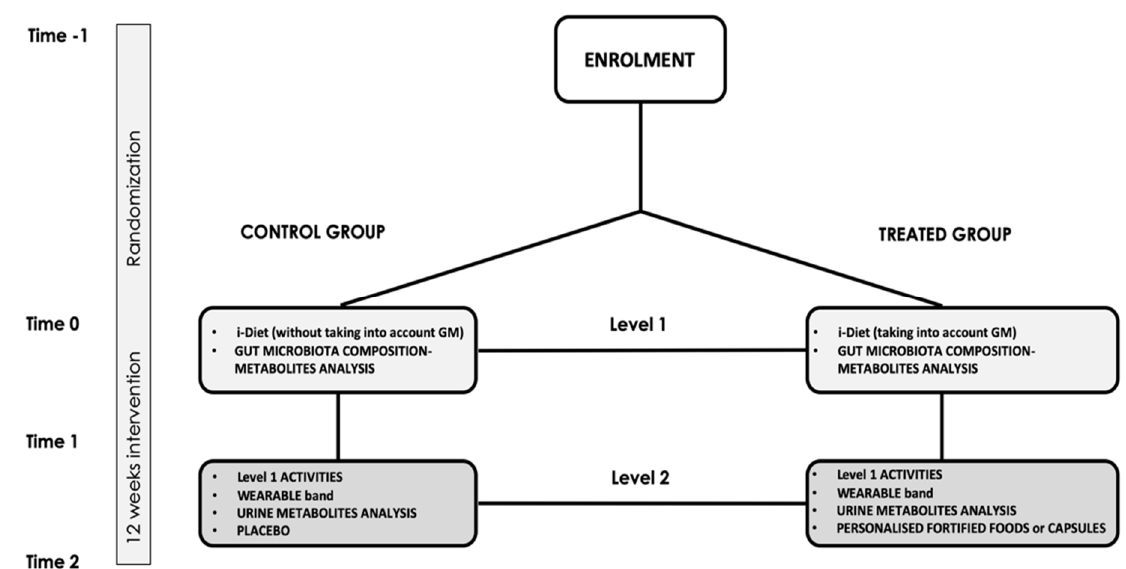
Figure 1. Intervention study.